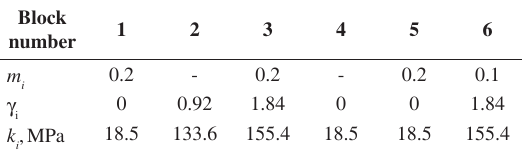
Table 2. Shear, shear strength and friction factor related to the rigid blocks and used in upper bound analysis. Block